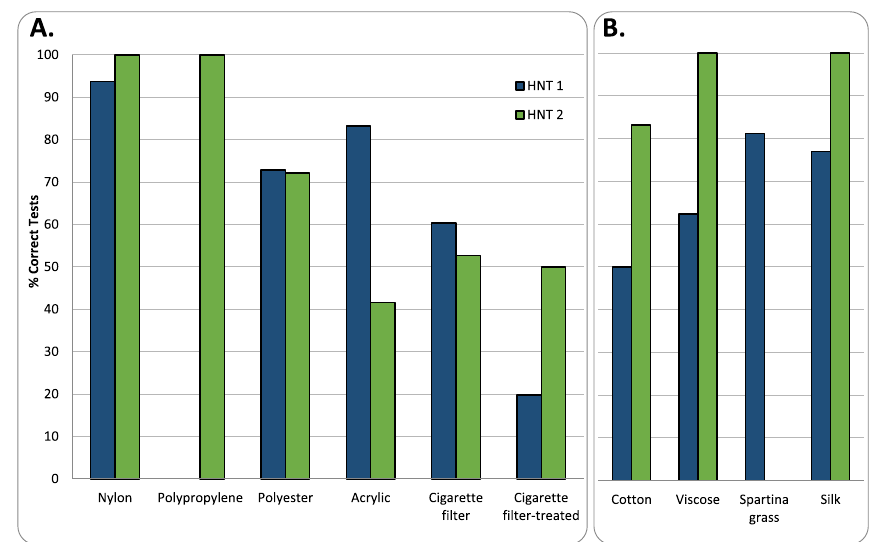
Fig. 2 Percent of correctly identified fibers in HNT 1 ( N the same soldering iron technique) by material type according to expected response, with materials expecting to pass the hot needle test in A) synthetics and cellulose acetate in cigarette filters and fail in B) semi-synthetic and natural